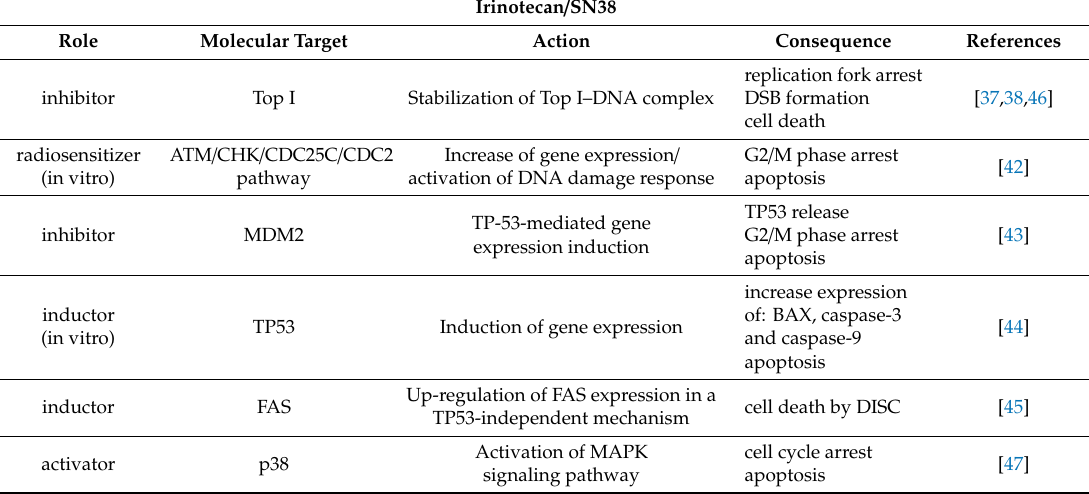
Table 1. Possible roles, molecular targets, actions, and consequences of irinotecan / SN38 application provided with references. ATM: Serine-protein kinase ATM, CDC2: cyclin-dependent kinase 1, CDC25C: M-phase inducer phosphatase 3, CHK: serine / threonine-protein kinase CHK, DSB: double-strand break, FAS: tumor necrosis factor receptor superfamily member 6, MAPK: mitogen-activated serine / threonine protein kinase, MDM2: mouse double minute 2 homolog, p38: mitogen-activated protein kinase p38, Top I: topoisomerase I, TP53: cellular tumor antigen